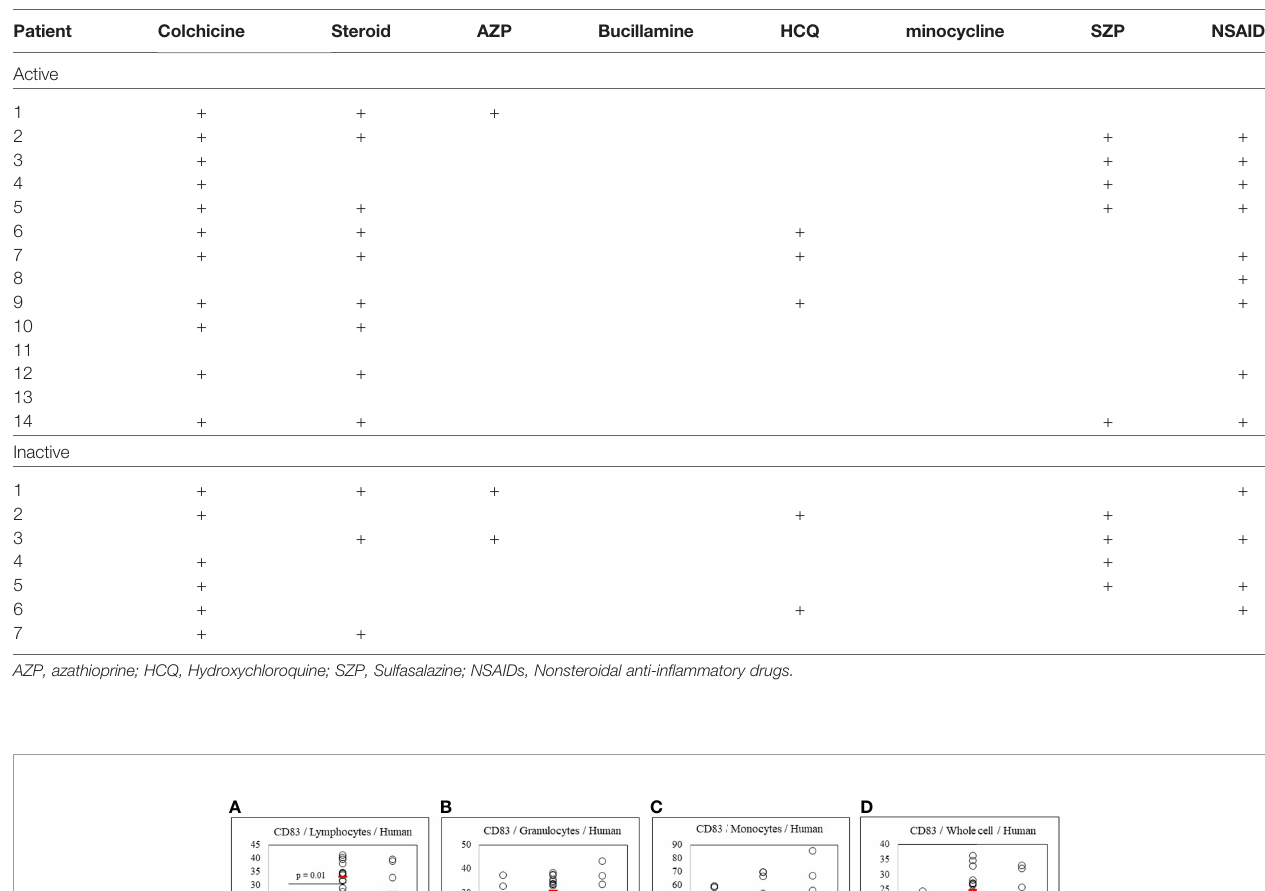
TABLE 2 | Therapeutic history of Behc ̧ et ’ s disease patients.